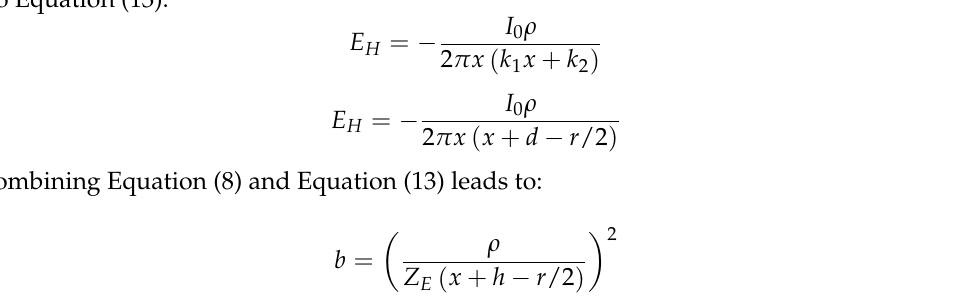
Figure 2 . Cylindrical electrode and its approximate equipotential surfaces.